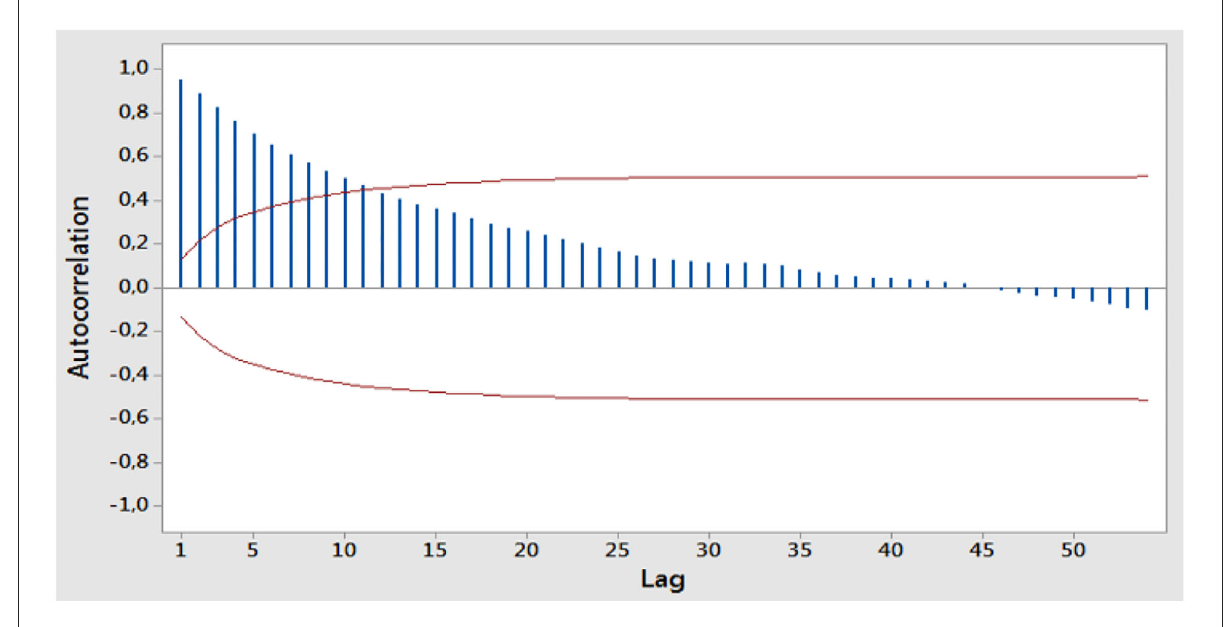
FIGURE4 ACF plot of stationary WTI oil data against